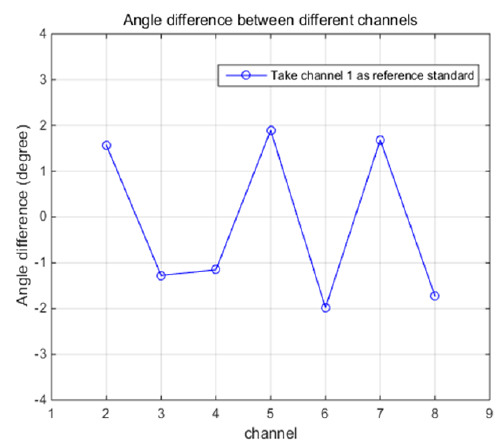
Figure 14. Angle errors between channels.